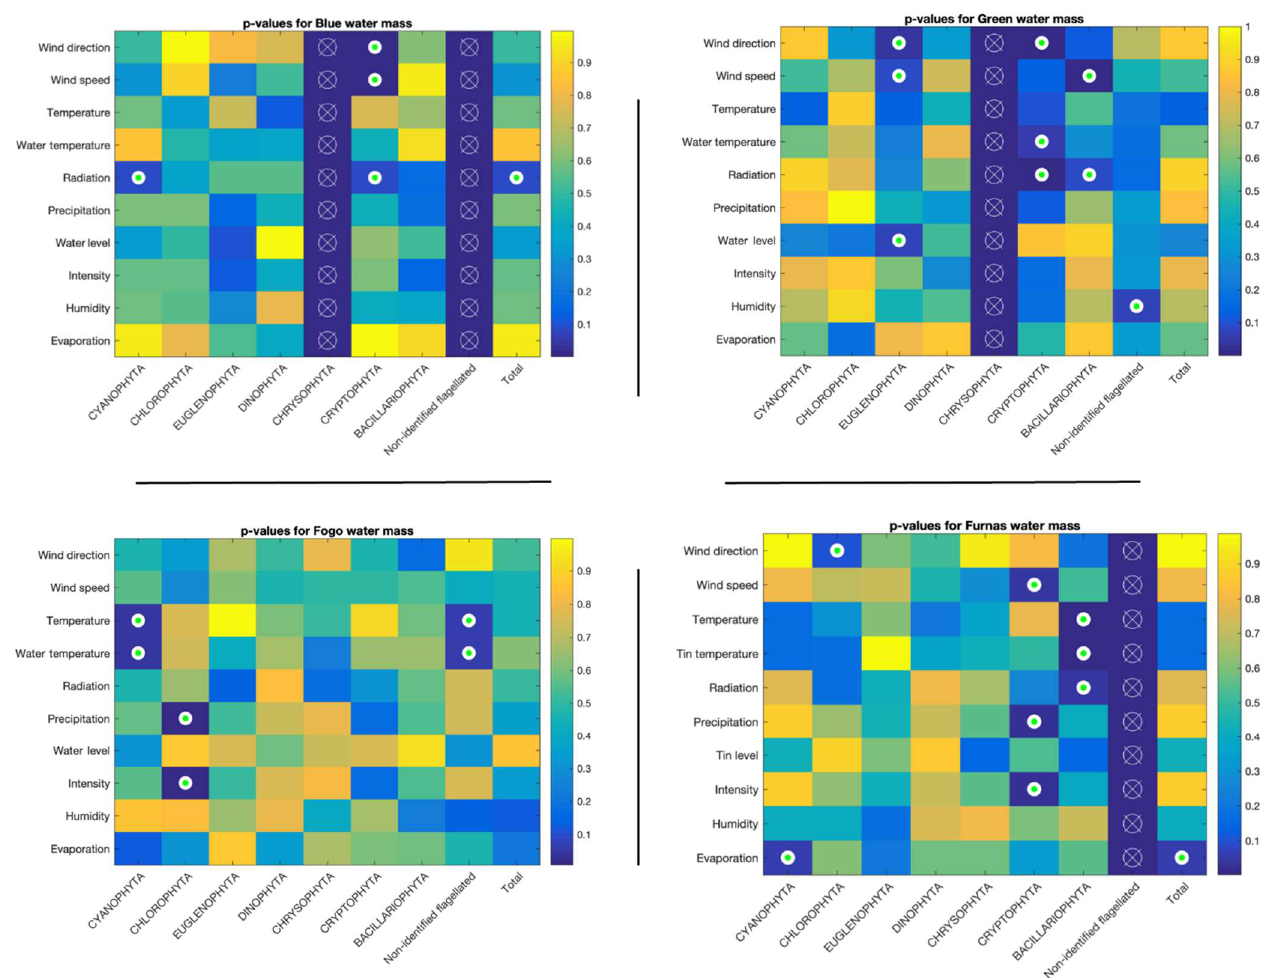
Figure 11. The p -values obtained from the ANOVA test of the effect of meteorological variables on the phytoplankton phyla, of Blue, Green, Fogo, and Furnas